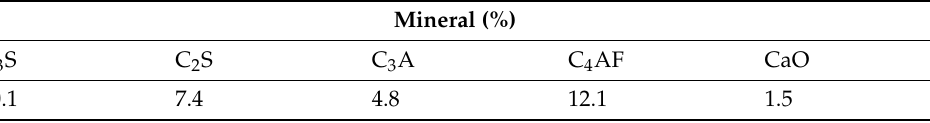
Figure 1. The granulometric distribution of the sand. Table 1. Mineralogical composition of the clinker.